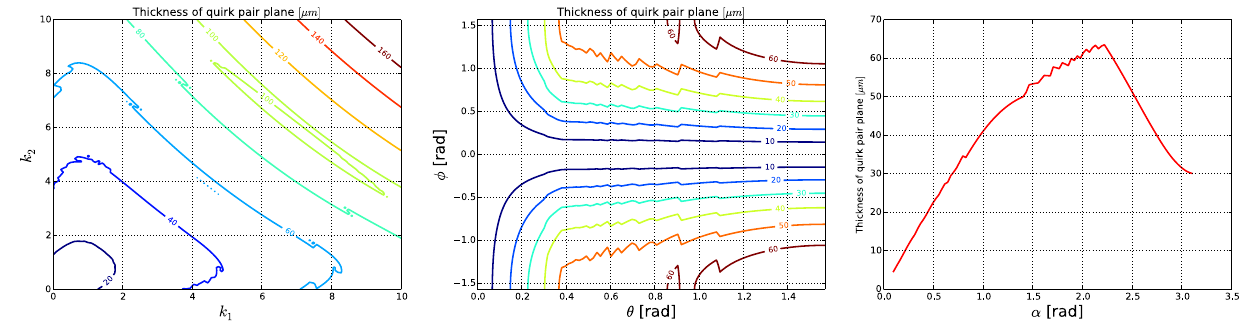
Fig. 3 Thickness of the quirk pair plane in the projected parameter space: k 1 − k 2 (left), θ − φ (middle), α (right). Parameters are set at benchmark points if they are not considered as varying. The confinement scale (cid:2) is fixed to be (cid:2) 0 for all